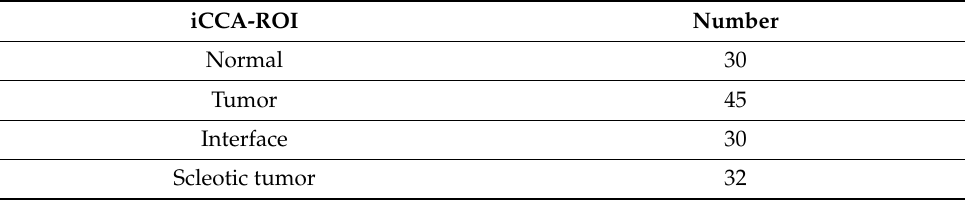
Table 2. Overview of number of ROIs included in the